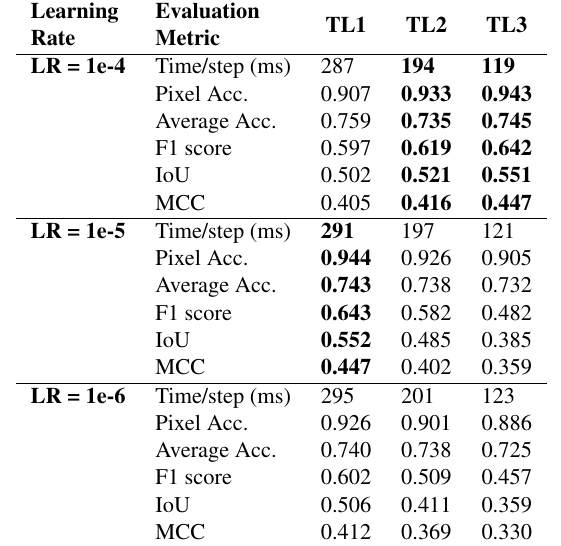
Table 4 . Validation results obtained on TR1 and TR2 datasets using three fine-tuning strategies TL1, TL2, and TL3, each eval- uated with three learning